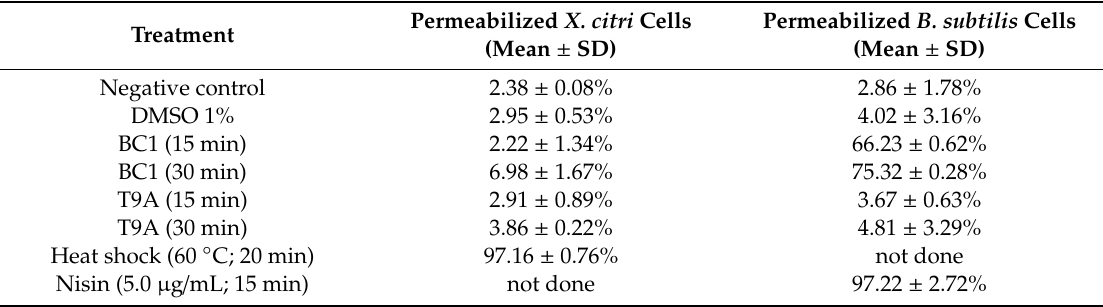
Table 2. Membrane permeabilization of X. citri and B. subtilis cells by chalcones.